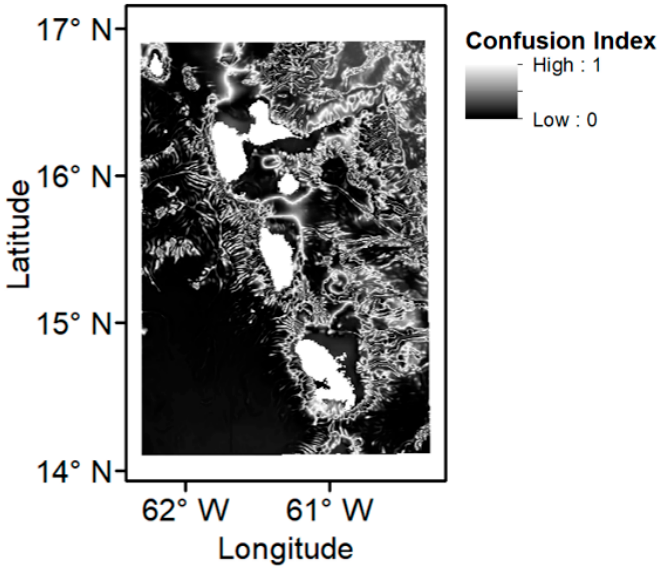
Figure 10. Confusion Index Map. Showing quantified clustering uncertainty for the smaller study area. Zones of high confusion appear white, while lower confusion is darker.